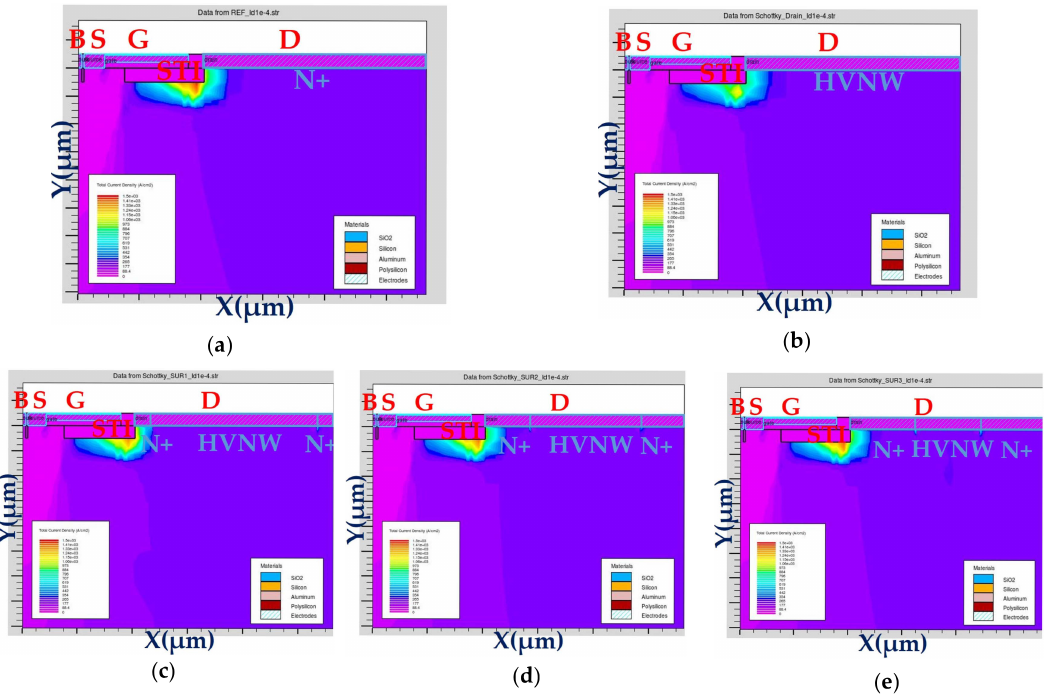
Figure 21. Total current-density diagrams of ( a ) Reference; ( b ) Schottky_Drain; ( c ) Schottky_SUR1;